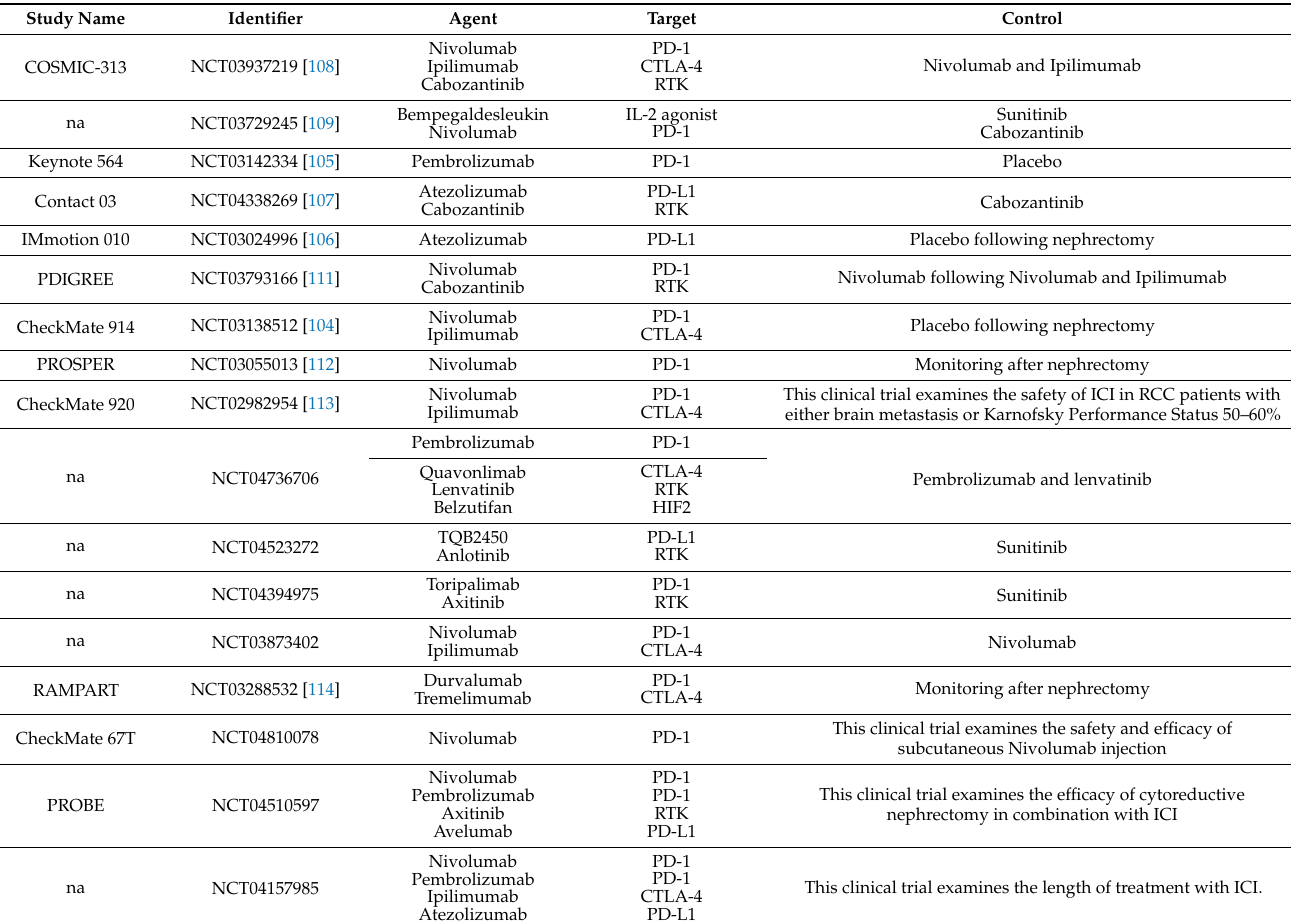
Table 2. Ongoing phase III clinical trials investigating immunotherapies for advanced